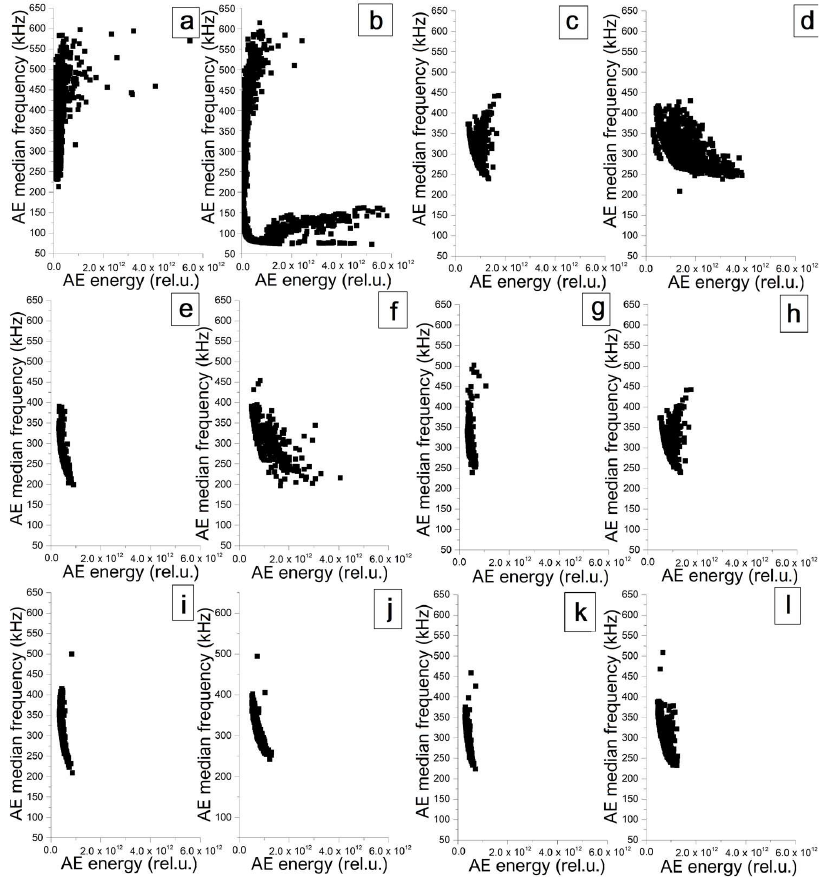
Figure 4. Relationships between AE median frequency and AE energy for the samples slid ( a , b ), CrN ( c , d ), ZrCrN(0.5) ( e , f ), ZrCrN(3.5) ( g , h ), ZrCrN(5) ( i , j ) ZrCrN(8) ( k , l ). Normal load 1N ( a , c , e , g , i , k ) and 6N ( b , d , f , h , j , l ).